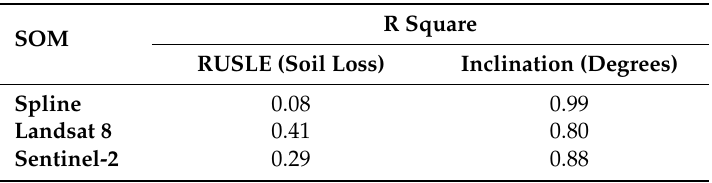
Table 6. R 2 statistics and slope inclination results concerning cross comparison between real data and the RUSLE results with various SOM estimation